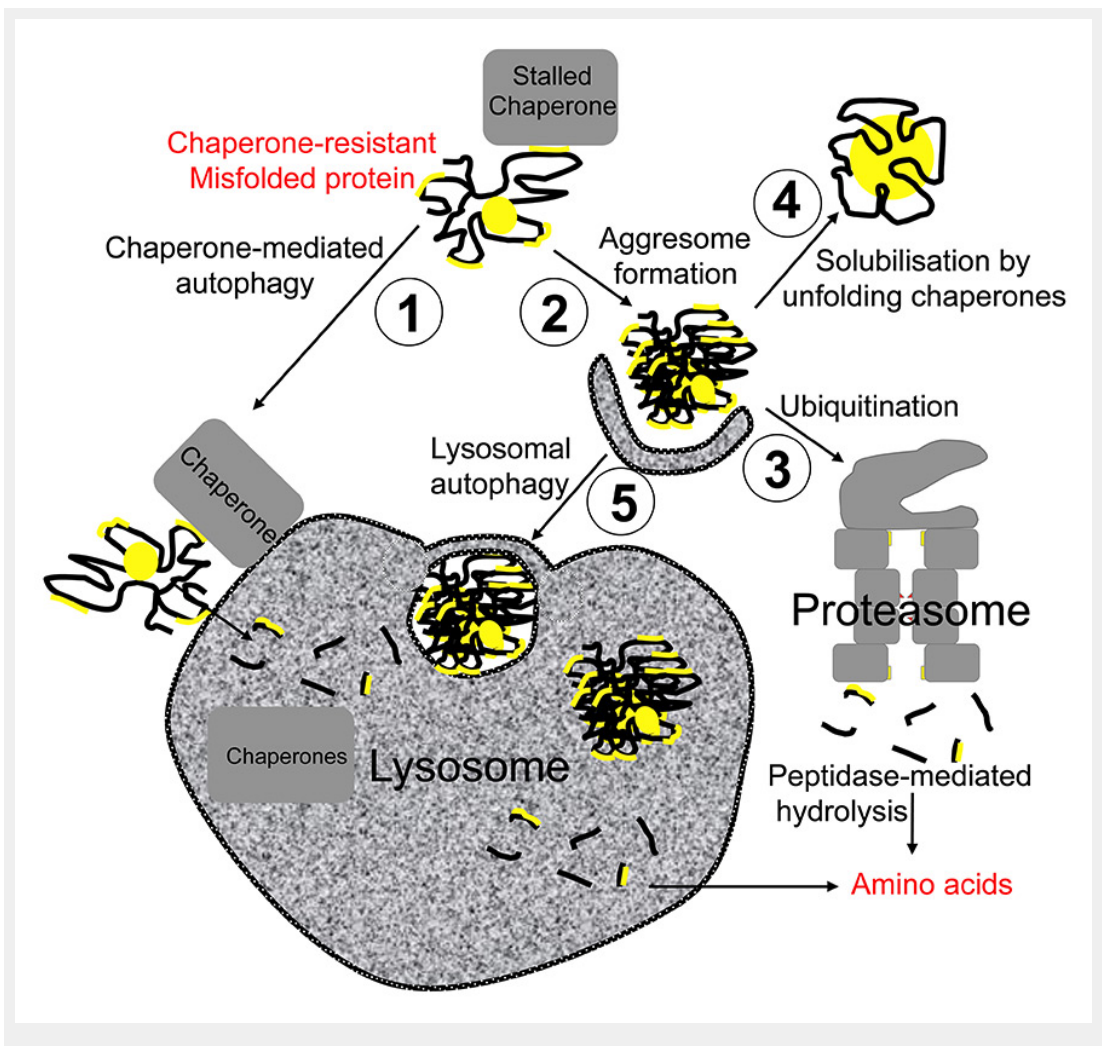
Figure 2 Compaction and degradation of irreversibly damaged polypeptides by the lysosome and the proteasome. When an irreversibly damaged polypeptide is over-sticky and is stalling an unfolding chaperone such as HSC70, the chaperone can target the polypeptide to the lysosome surface (step 1), where it will be specifically imported by specific transporters and degraded by chaperone-mediated autophagy. Alternatively, it may be compacted by the aggresome machinery (step 2), ubiquitinated, unfolded and degraded by the proteasome (step 3). When not ubiquitinated, the polypeptide may be actively disaggregated by unfolding chaperones and reach the native state (step 4). Alternatively, proteasome-resistant aggresomes may become enveloped by autophagosome membranes and imported into the lysosome to be degraded by autophagy (step